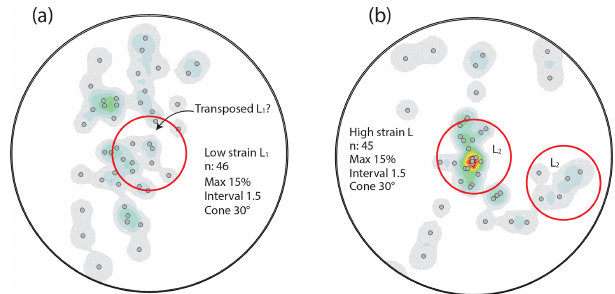
Figure 20. Lower-hemisphere equal-area stereographic projections of lineation throughout the WSB. Cones represent 30 ◦ circles. (a) L 1 stretching and mineral lineation measured on S 1 foliation planes in low-strain blocks. (b) Stretching and mineral lineation measured in high-strain zones.